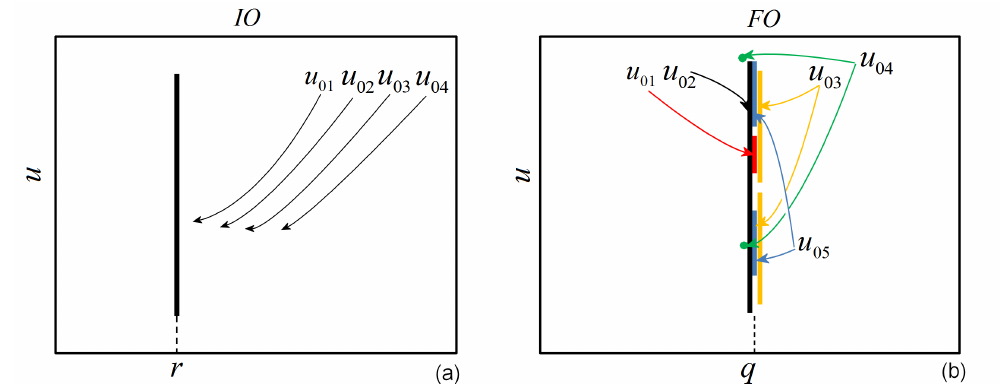
Figure 6. Sketch of diagrams of bifurcations. ( a ) The IO case; ( b ) FO case. u 0 i , i = 1,2, . . . ,5 are initial conditions.